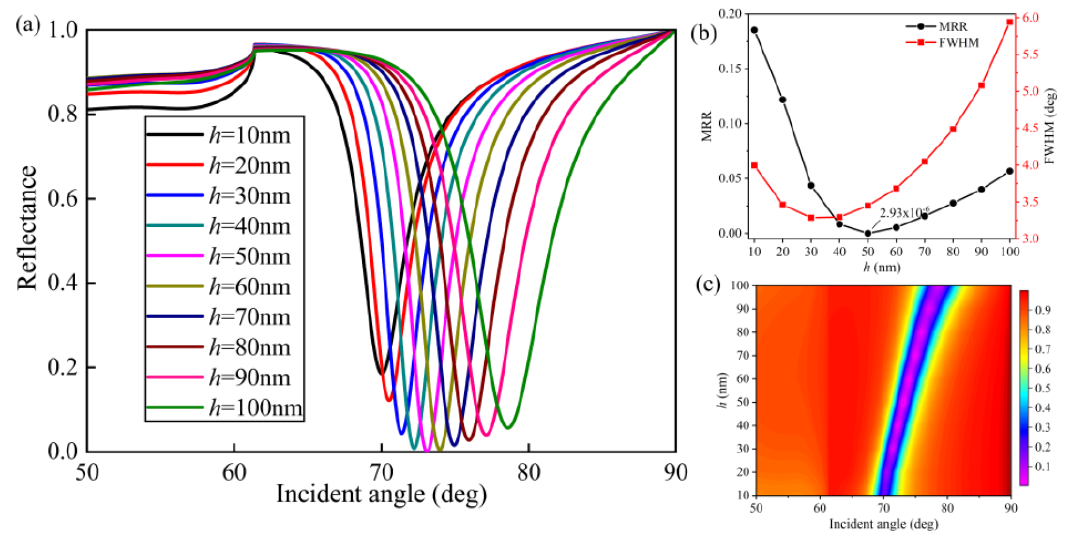
Figure 4. Influence of the grating height ( h ) on reflectance: ( a ) SPR curves of various grating heights; ( b ) MRR and FWHM as a function of h ; ( c ) contour plot of the reflectance ( T = 15 nm, m = 10 nm, w = 50 nm, Λ = 100 nm, and L = 1).